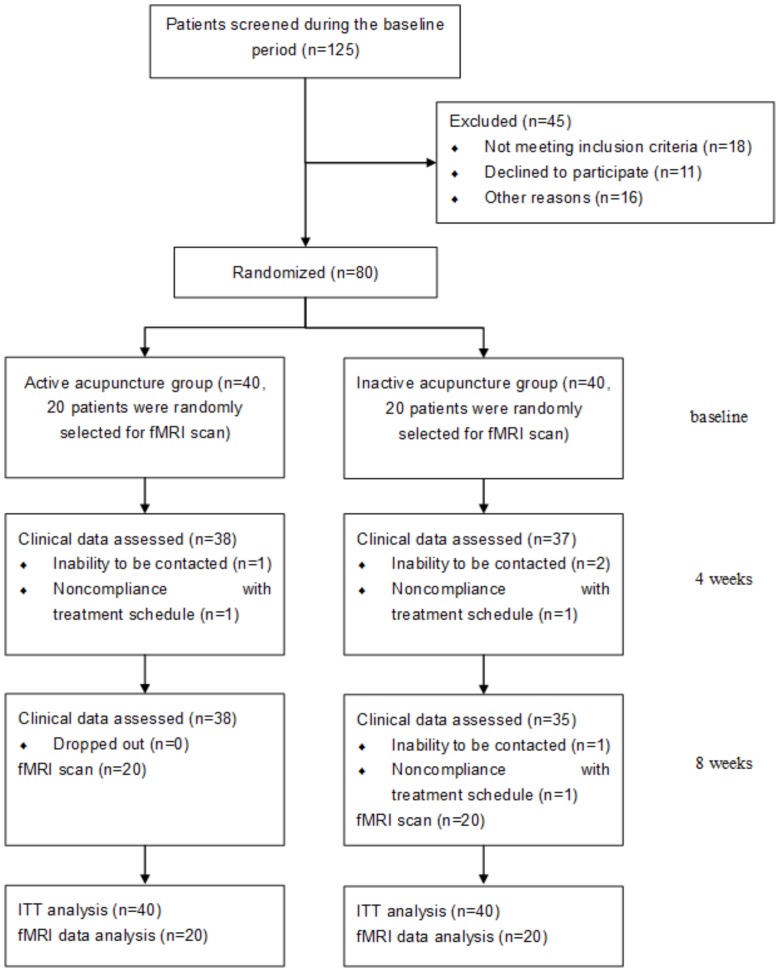
The flow chart of study.The flow chart of this study according to the CONSORT Statement.